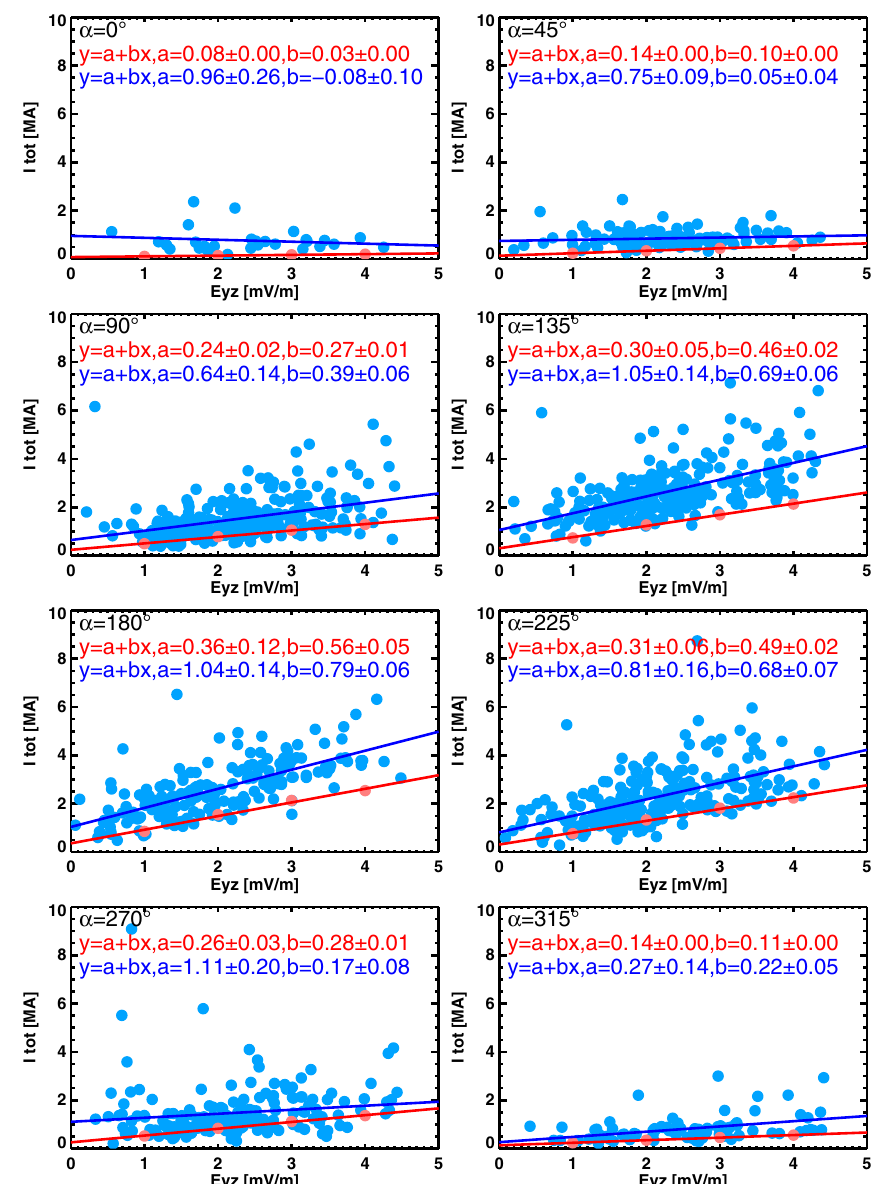
Fig. 5. Dependence of total current on solar wind electric field, E yz , and IMF clock angle, α , for the Iridium observations (blue dots) and the BATS-R-US plus RCM simulations (red dots). The lines of the respective color represent the linear least-squares fit functions noted at the top of each